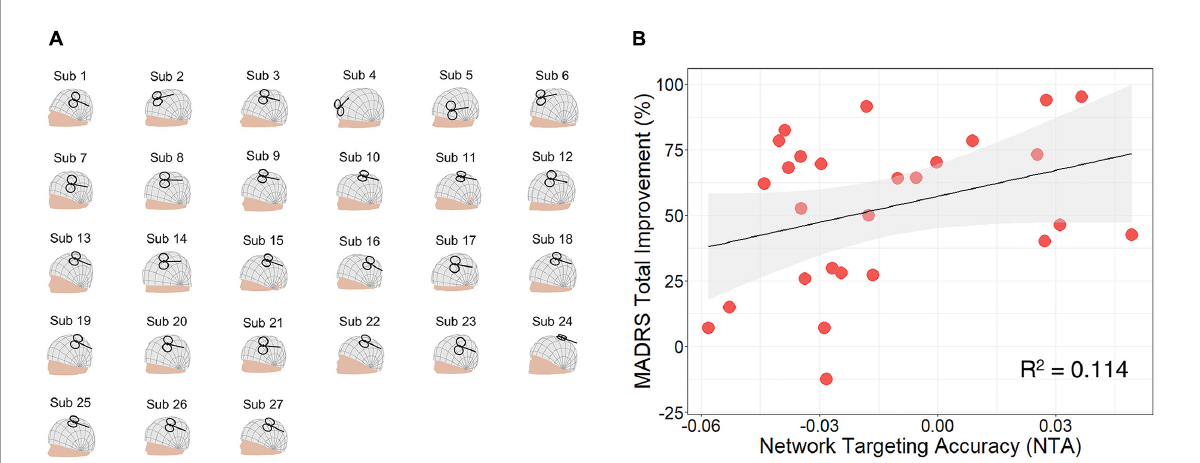
FIGURE3 Network targeting accuracy predicts treatment efficacy in the clinical major depressive disorder (MDD) cohort. (A) Coil placement of left prefrontal cortex (PFC) patients shown on individual head models. (B) Correlation between network targeting accuracy (NTA) and Montgomery–Asberg depression rating scale (MADRS) total improvement ( N = 27, p = 0.043, one-tailed).